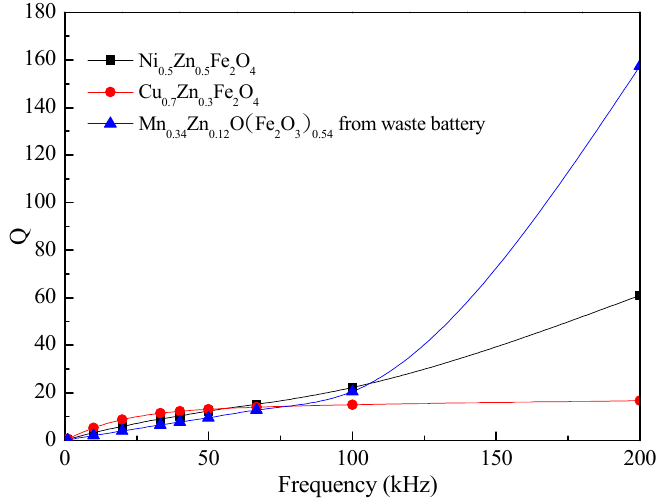
Figure 8. The effect of forming sintering on the Q-value for different systems.